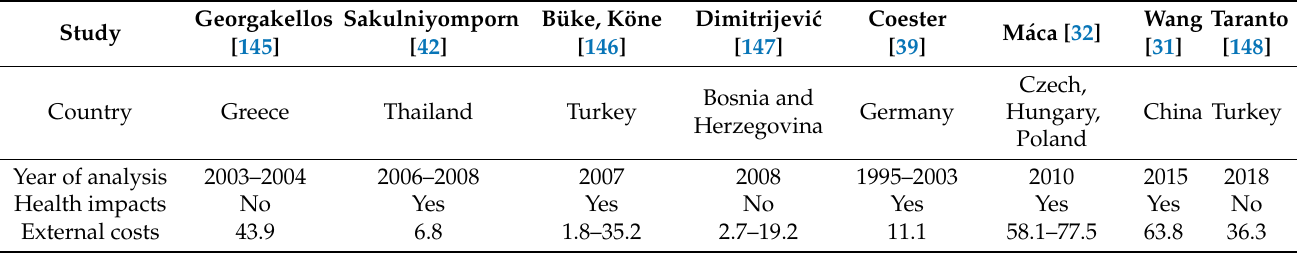
Table 6. External costs of air pollution caused by lignite combustion € × MWh − 1